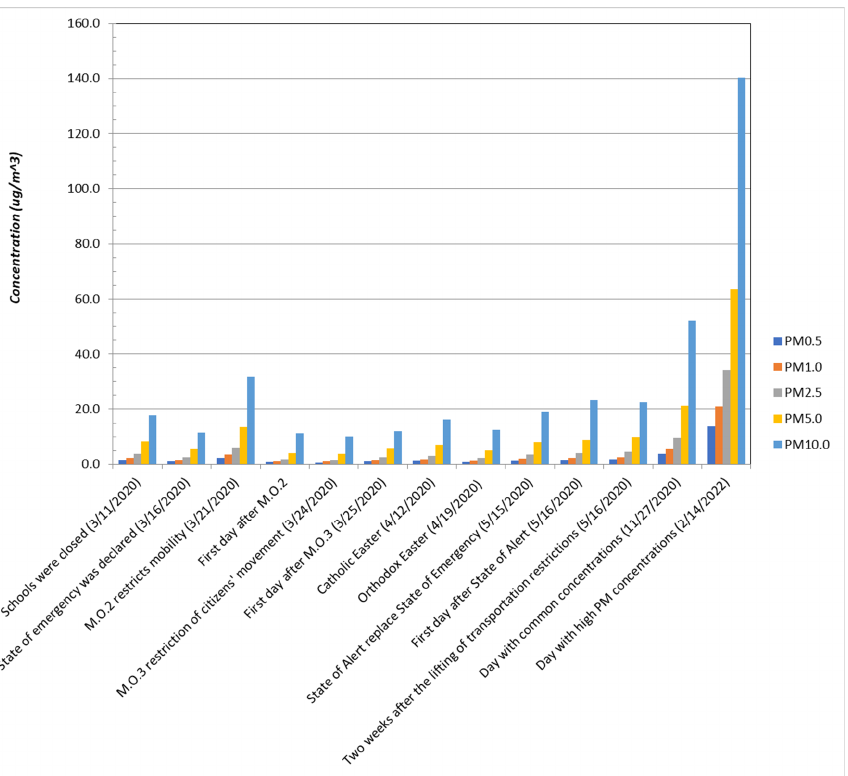
Figure 3. Time series of the concentrations of the size-segregated mass fractions of particulate matter (µg m − 3 ) recorded in Ploiesti in 2020 during various important moments that characterized the lockdown period compared to a typical day without/with PM signi fi cant load.